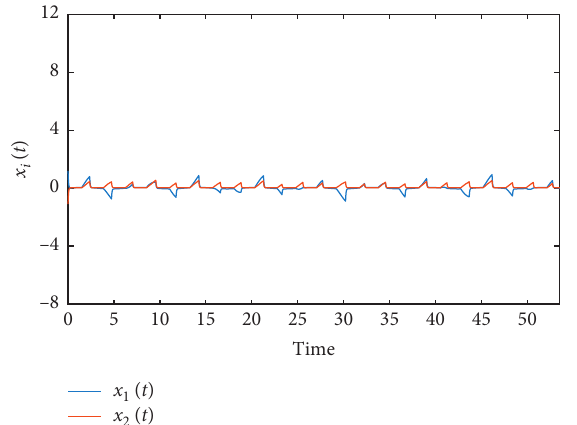
Figure 11: State trajectories x observer-based E-APIC.